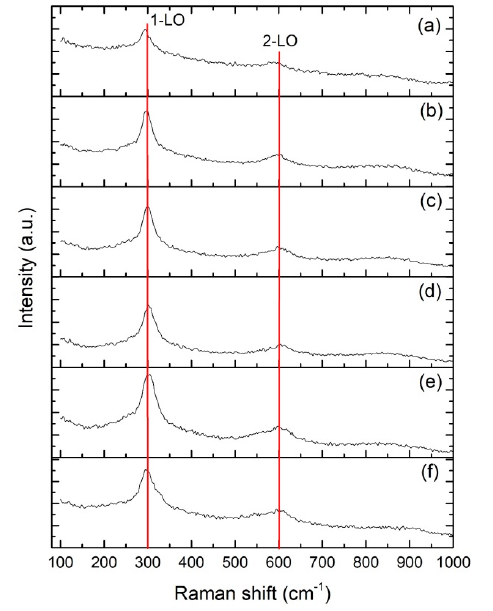
Figure 9. Raman spectra recorded with the 455 nm laser line for pure CdS and Zn x Cd 1 − x S solid solutions: ( a ) pure CdS; ( b ) Zn 0.05 Cd 0.95 S; ( c ) Zn 0.1 Cd 0.9 S; ( d ) Zn 0.15 Cd 0.85 ; ( e ) Zn 0.2 Cd 0.8 S and ( f ) Zn 0.25 Cd 0.75 S.